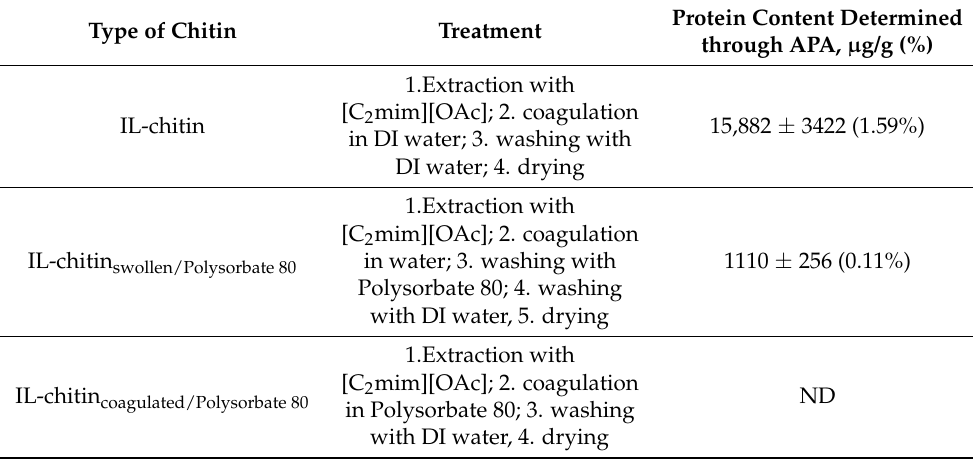
Table 2. Treatment of IL-chitin (wet and gel form) with Polysorbate 80 and APA analyses results. Protein Content Determined Type of Chitin Treatment through APA, µ g/g (%) 1.Extraction IL-chitin